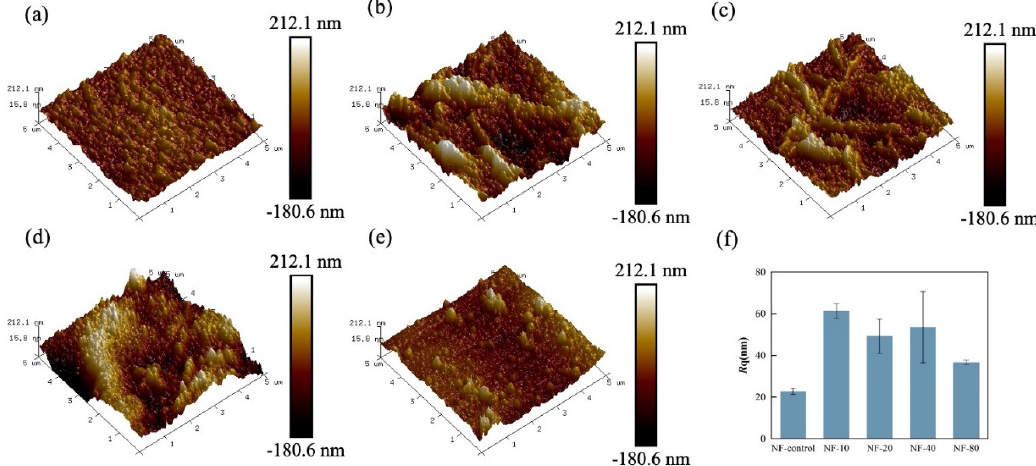
Figure 3. AFM micrographs of all resulting membranes: ( a ) NF-control, ( b ) NF-10, ( c ) NF-20, ( d ) NF-40, ( e ) NF-80; ( f ) the roughness of fabricated membranes.